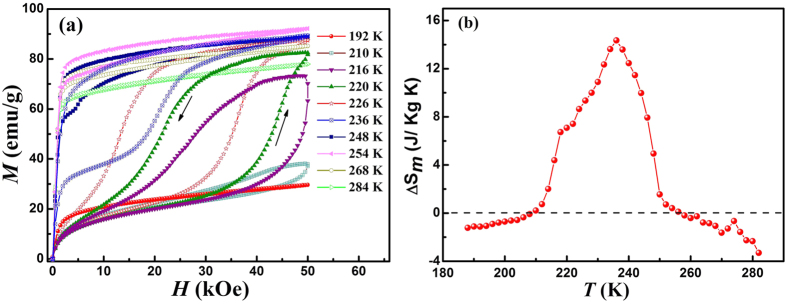
(a) Isothermal magnetization M(H) curves for Ni50Mn34In15.5Al0.5 alloy at selected temperatures. (b) Temperature dependence of isothermal magnetic entropy change ΔSm in the magnetic field of 50 kOe. Arrows indicate the direction of field variation.